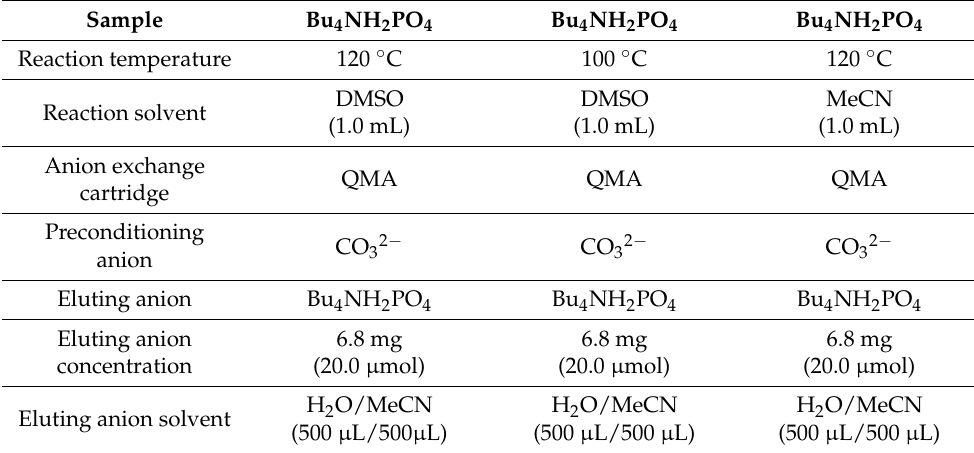
Table 5. Specified details for the second manual stability tests of FE-PE2I and OTsE-PE2I and the manual fluorination reaction of [ 18